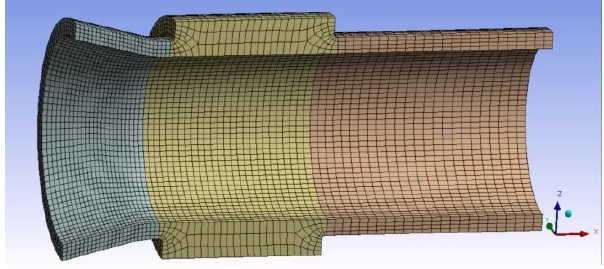
Figure 7. A grid laid on the solid model of the burner device.